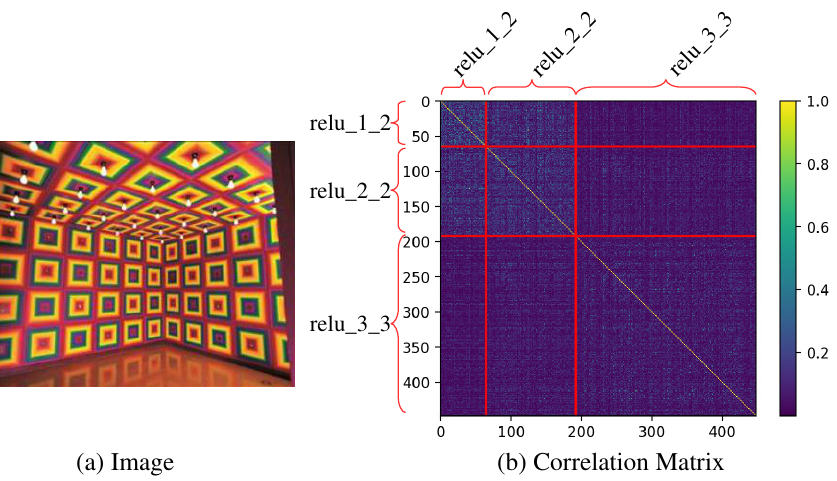
Figure 1. Correlation between channels ( b ) in the multi-scaled feature maps of an input image ( a ) extracted from the pre-trained VGG16 feature network [2]. The area corresponding to each scale of feature maps (relu_x_x) is divided by red lines. The diagonal rectangles of the correlation matrix ( b ) represent the intra-scale correlation between channels of the same scaled feature map (channels of relu_x_x), and the other rectangles represent the inter-scale correlation between the channels of two different scaled feature maps (channels of relu_x_x and relu_y_y).